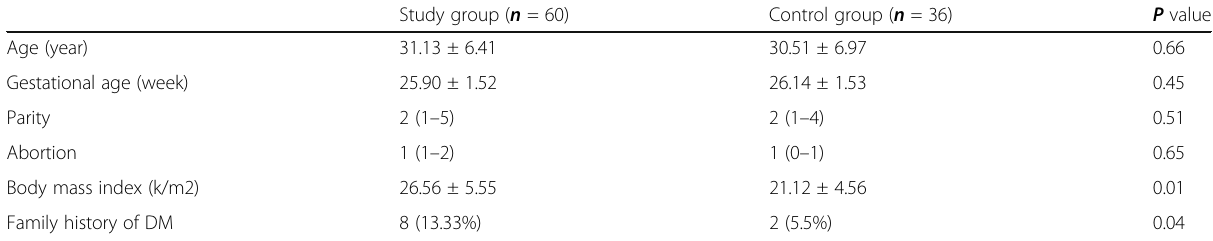
Table 1 Baseline data of enrolled